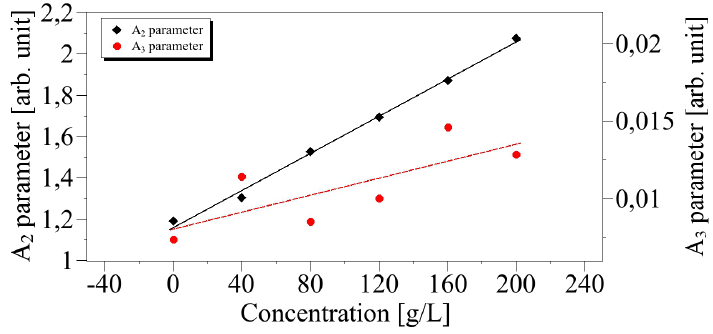
and A and the 2 3